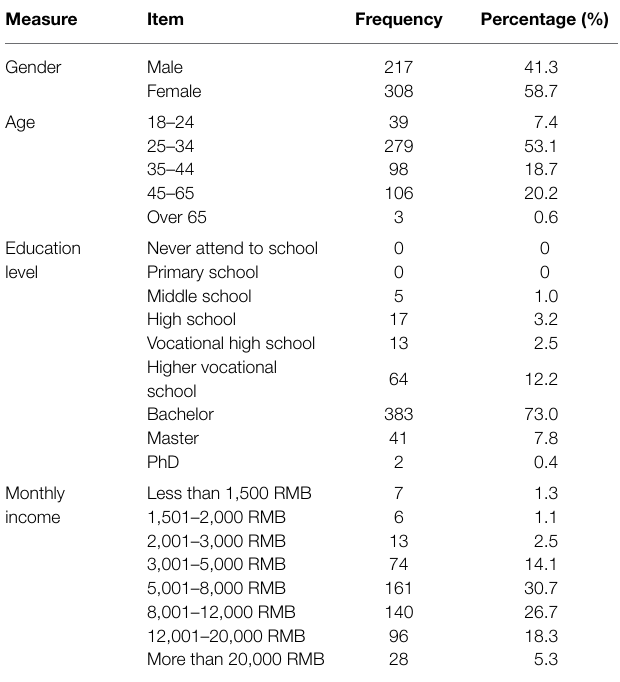
TABLE 1 | Demographic characteristics of the